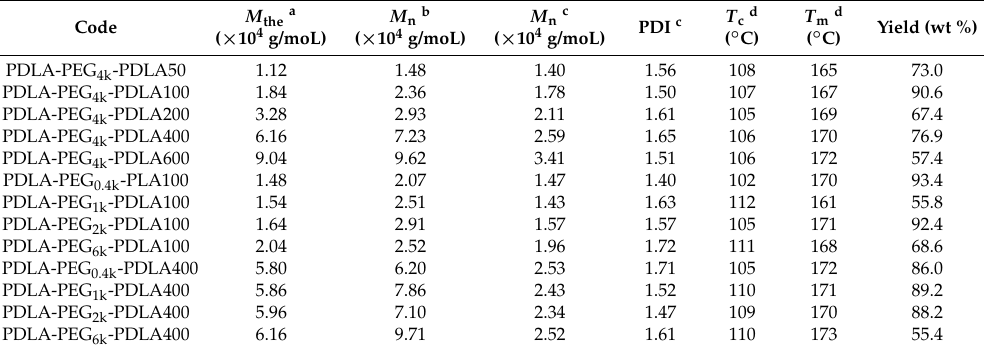
Table 1. Synthesis and characterization of poly( D -lactide)-poly(ethylene glycol)-poly( D -lactide).